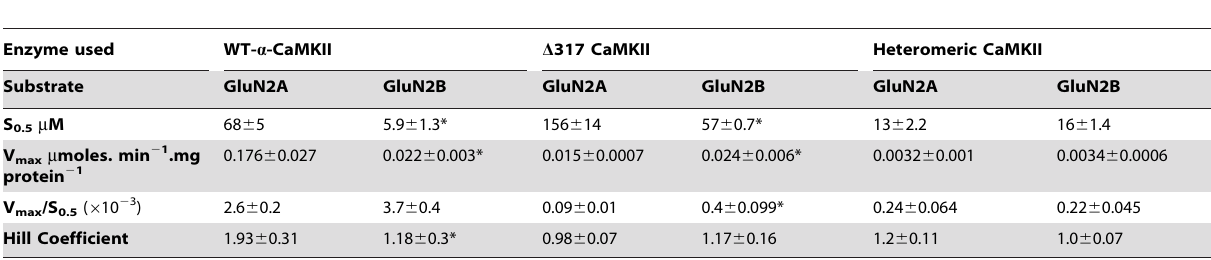
Table 1. Kinetic parameters of WT, Monomeric and Heteromultimeric CaMKII for ATP.